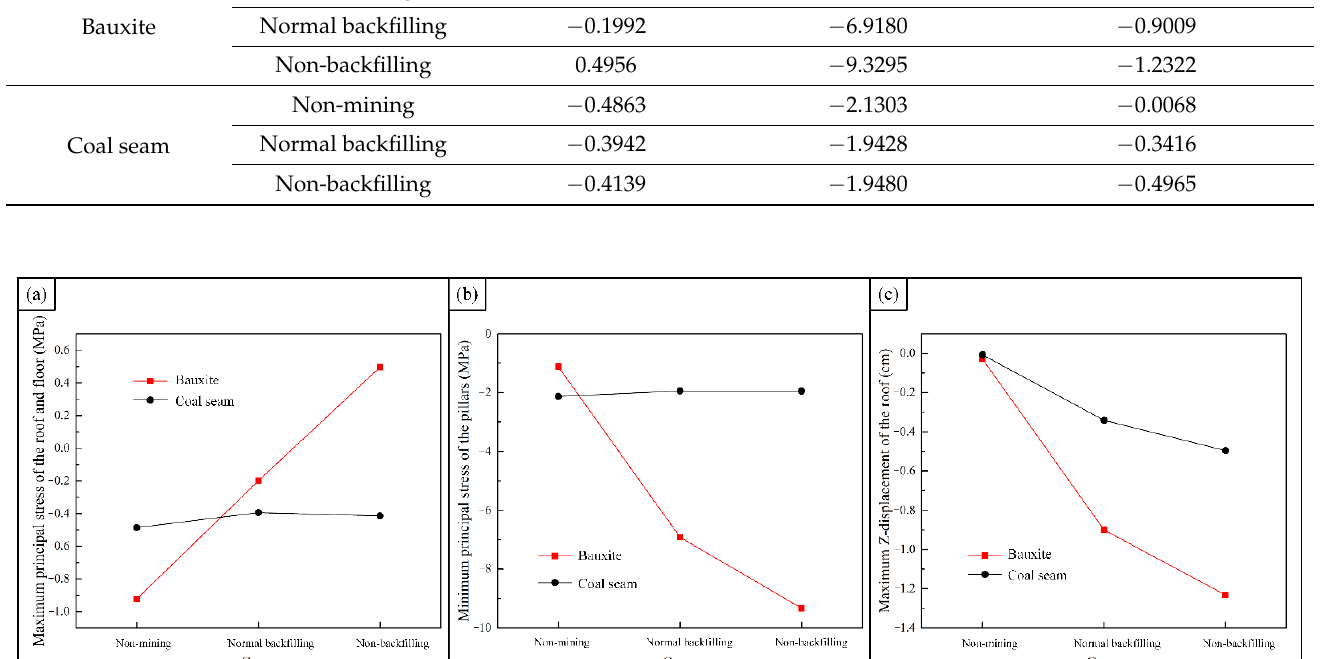
Figure 10. Charts of extreme values: ( a ) maximum principal stress of roof; ( b ) minimum principal stress of pillar; ( c ) maximum displacement of roof in Z-direction.